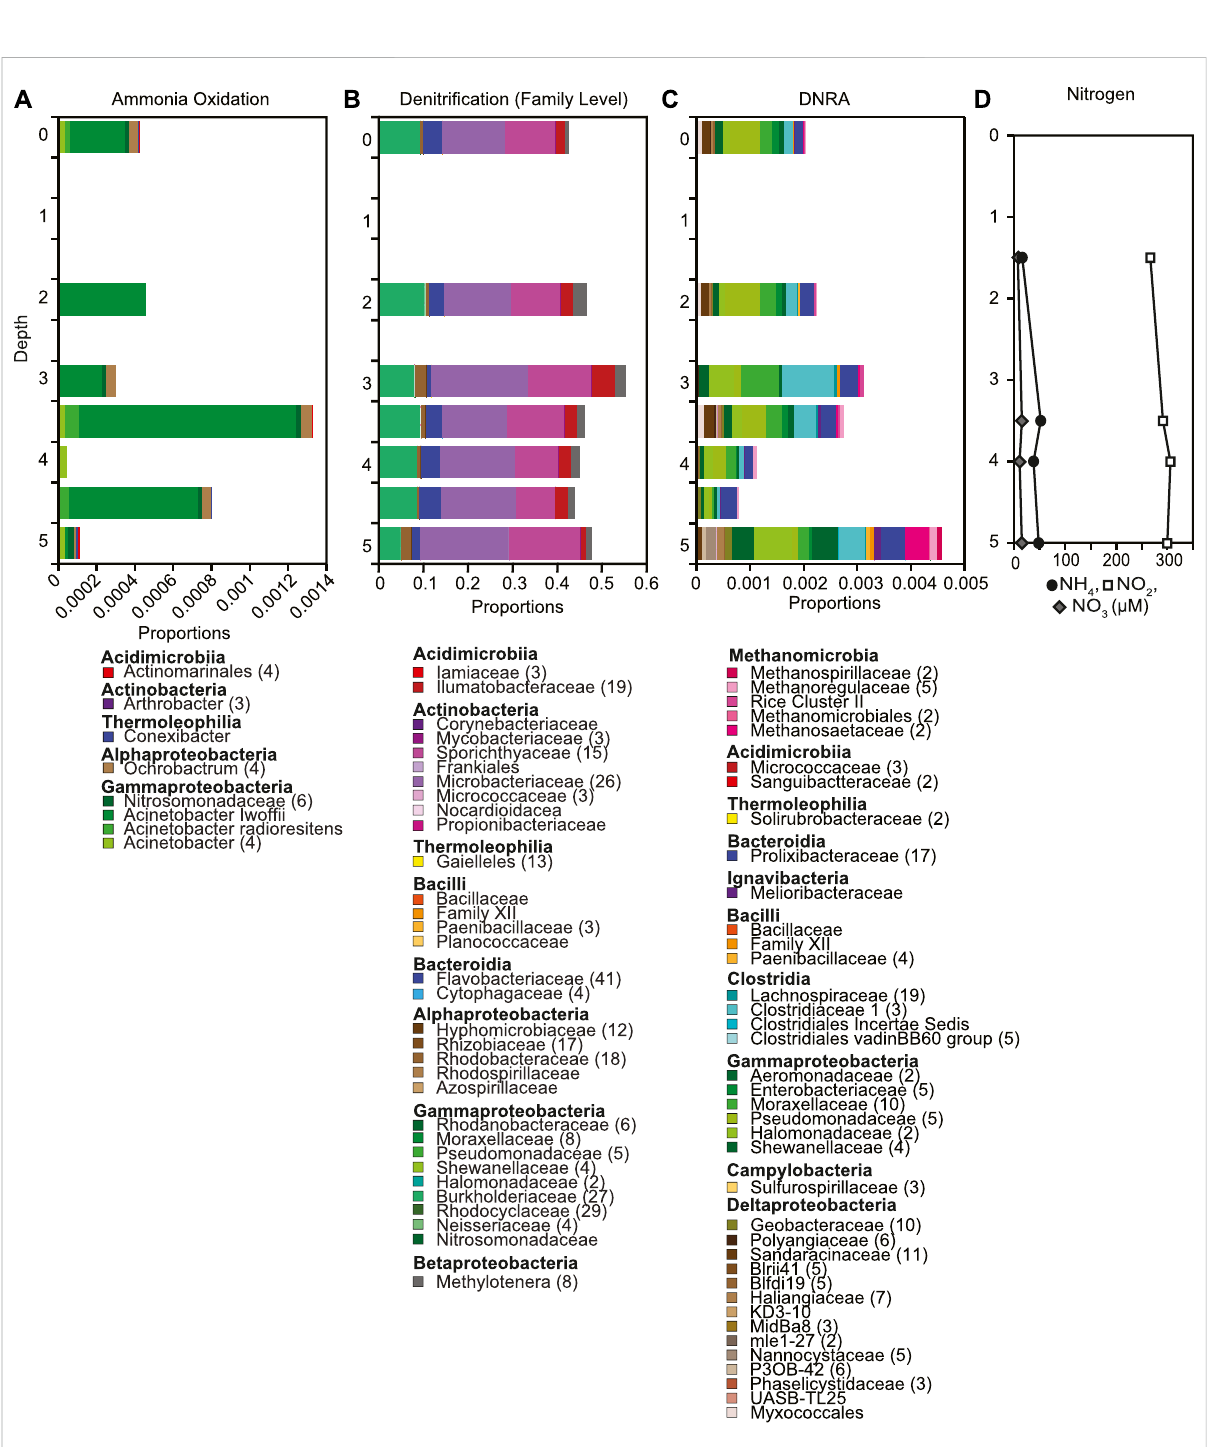
FIGURE 6 Depth pro fi les of putative (A) ammonia oxidizers, (B) denitri fi ers, (C) DNRAbased on 16S rRNA gene sequences, as well as (D) concentrations of nitrate, nitrite and ammonia down the water column. (A – C) . The number of ASVs included in each taxonomic group is included with the number given after the taxonomic name. If no number is given, the group only contains one